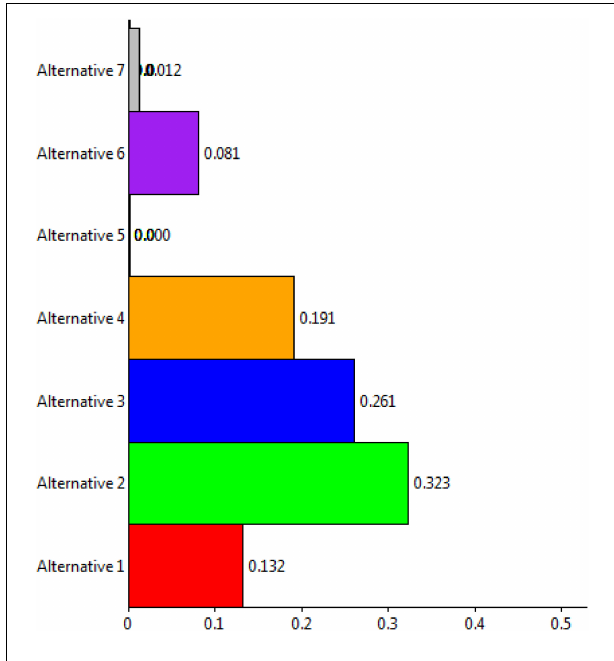
FIGURE 10 | Alternative